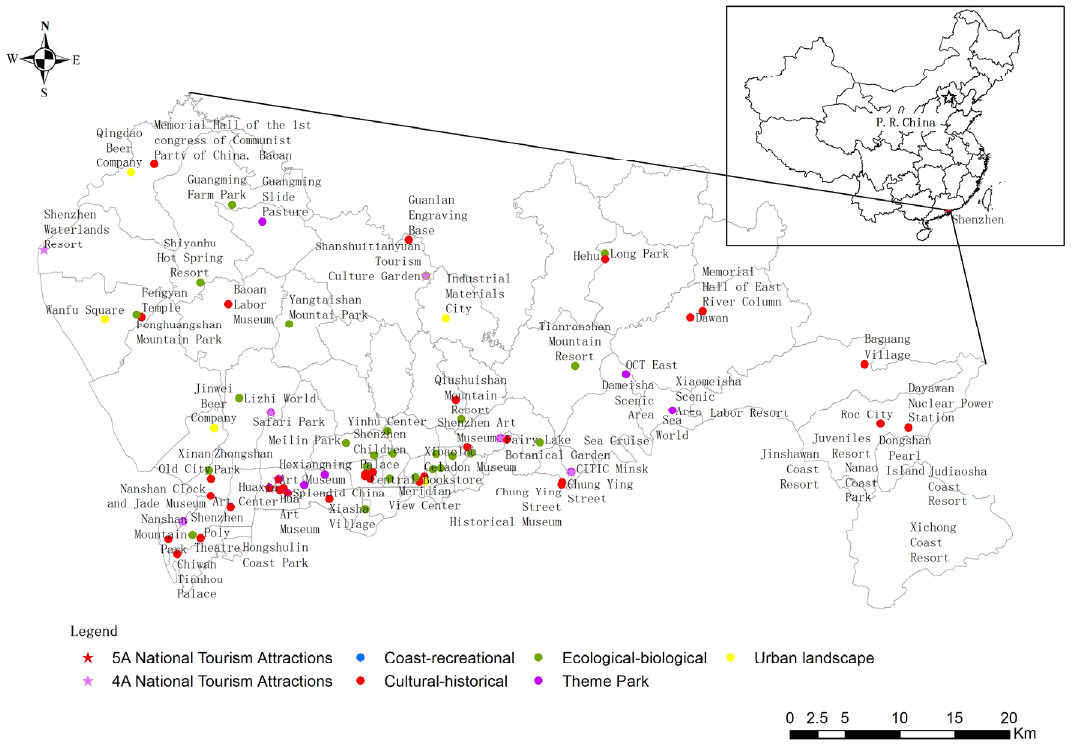
Figure 1. Spatial distribution of 86 tourist attractions in Shenzhen. Data source: Drawn by adding relevant information from the official website of Shenzhen Culture, Sports, and Tourism Bureau to a GIS database